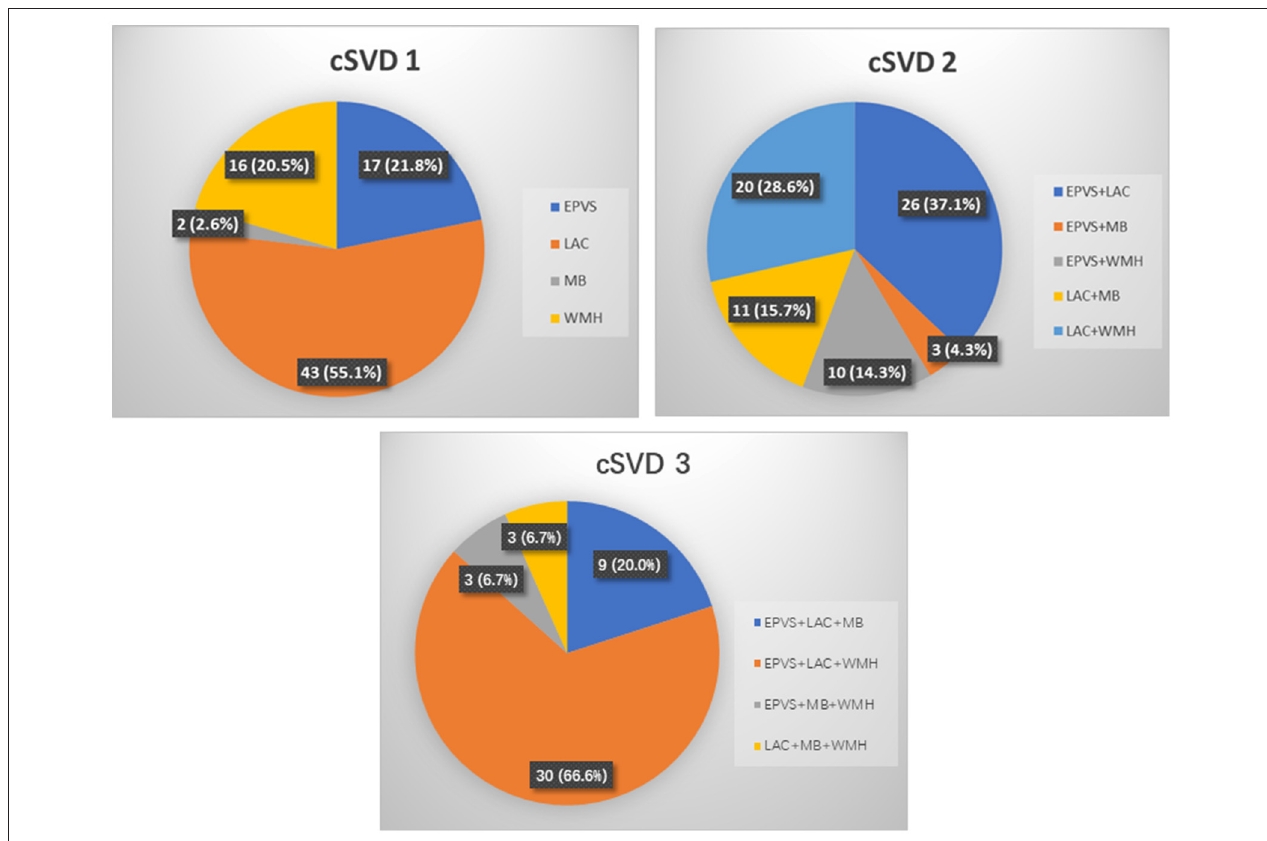
FIGURE 2 | Distribution and combinations of cSVD markers according to the total cSVD score. cSVD, cerebral small vessel disease; EPVS, enlarged perivascular spaces; LAC, lacune; MB, microbleed; WMH, white matter